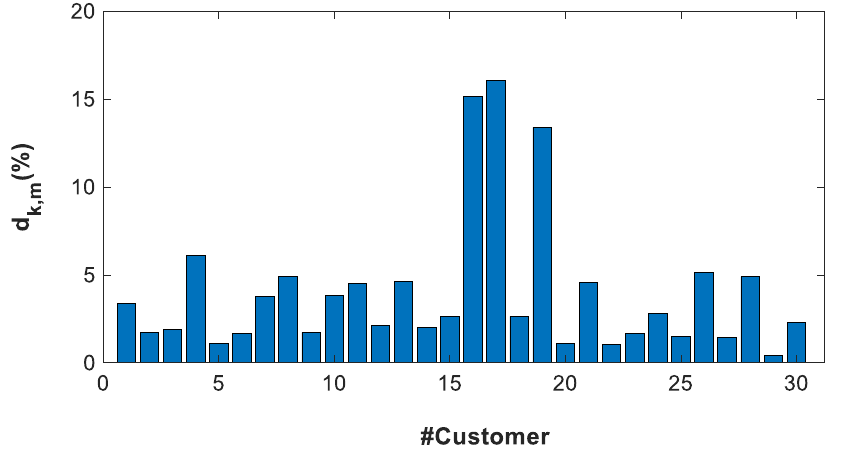
(cid:92) Y ABAB , m , of cluster k = ABAB with the Figure 15. The partial deviation of the full power profiles, Figure 15. The partial deviation of the full power profiles, 𝑌 𝐴𝐵𝐴𝐵,𝑚 ̂ , of cluster k = ABAB with the (cid:92) Y ABAB . The deviation is normalized by the contractual power respect to the estimate power profile respect to the estimate power profile 𝑌 𝐴𝐵𝐴𝐵 ̂ . The deviation is normalized by the contractual power of the cluster ABAB (P ABAB = 16.5 of the cluster ABAB (P ABAB = 16.5 kW).